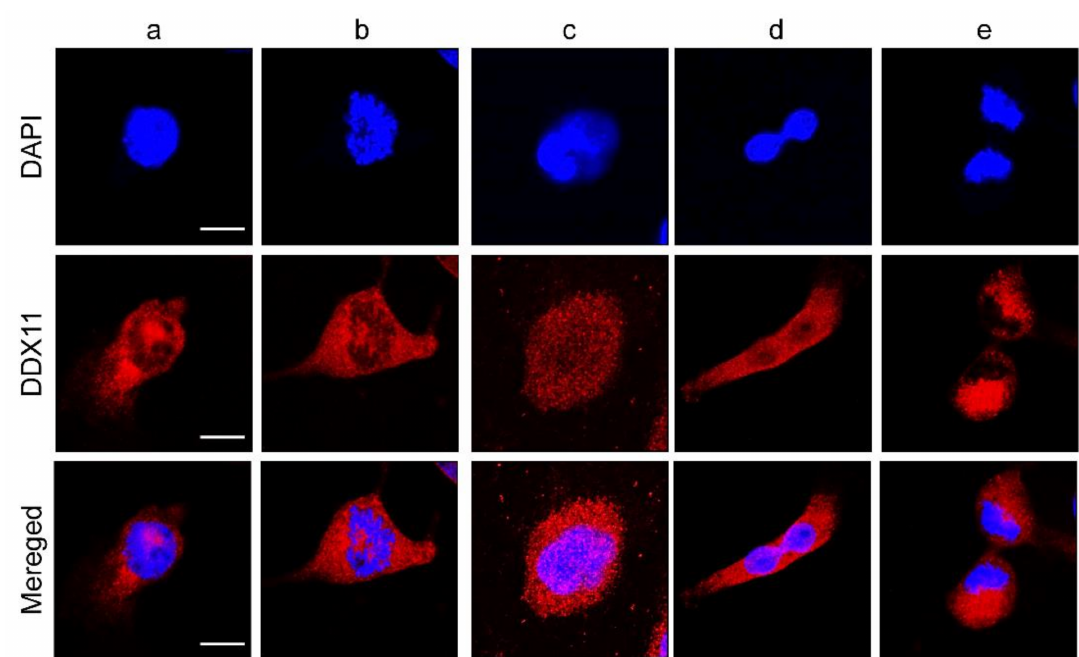
Figure 2. Immunofluorescence analysis representing DDX11 expression in renal cell carcinoma cells. DDX11 expression in 786-O cells during interphase ( a ), prophase ( b ), metaphase ( c ), telophase ( d ), and late telophase ( e ); DDX11 (pseudocolored red), nuclei (pseudocolored blue; DAPI), Scale bar: 10 µ